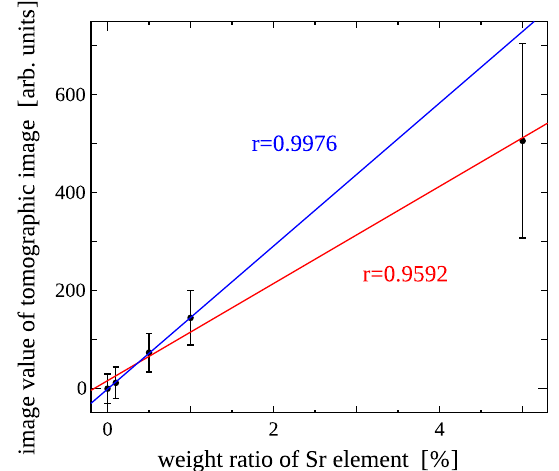
8. The image value of the subtraction tomographic image as a function of Sr concentration (weight ratio) in the sample. Red and blue lines represent linear regression for the data set with and without 5%-concentration point,